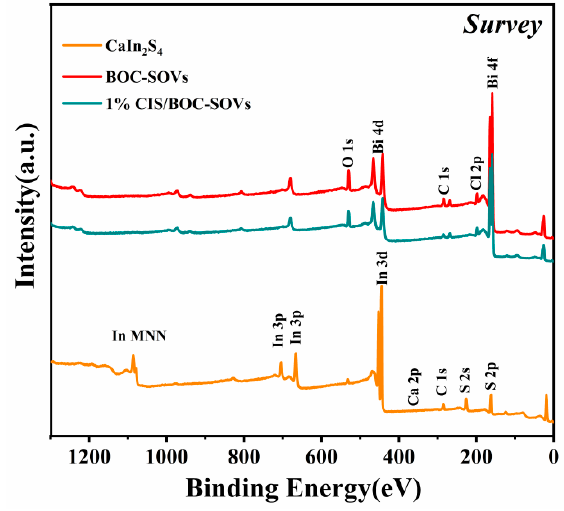
Figure 2. XPS survey spectrum pure BiOCl, pure CaIn 2 S 4 and 1 wt% CIS/BOC-SOVs.